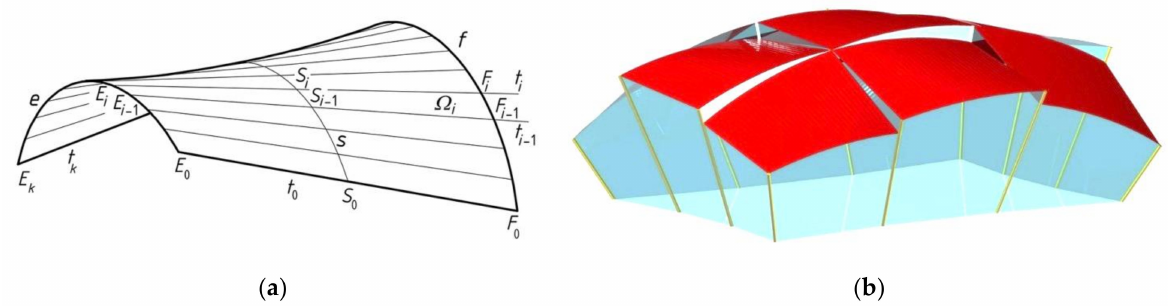
Figure 6. ( a ) A simplified geometric smooth model of a complete corrugated shell sheeting; ( b ) A simplified geometric model of a building free form roofed with complex corrugated shell sheeting